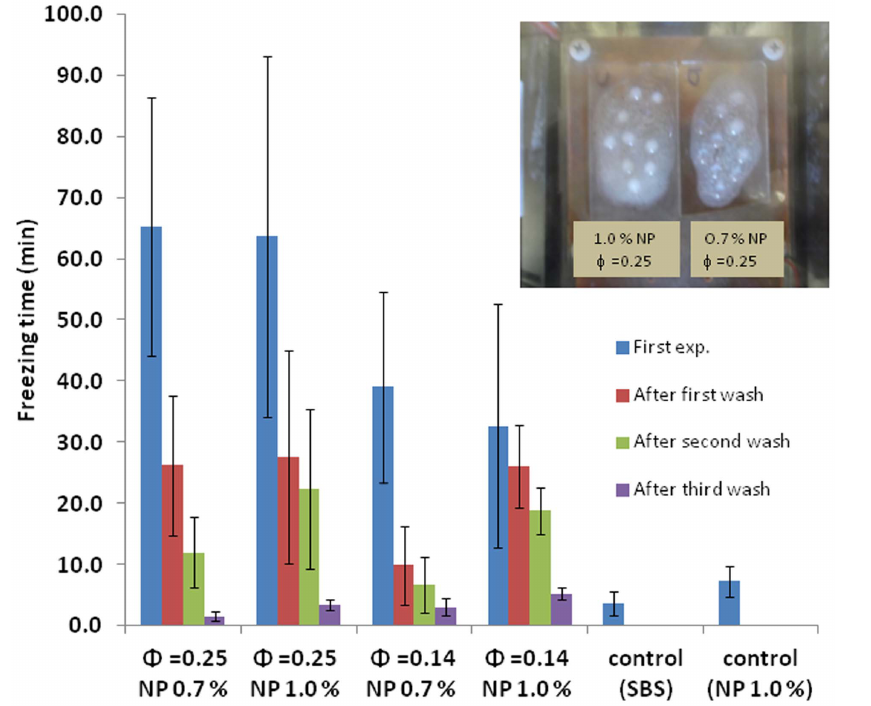
Figure 9. Average freezing times water droplets on dry composite membranes with gelation of the internal phase, SBS (control) and SBS with 1.0% nanoparticle concentration (control). The inset image is taken from temperature and humidity controlled chamber, where the composite with 1% (w/v) nanoparticle concentration (left, W =0.25) and 0.7% (w/v) nanoparticle concentration (right, W =0.25) was monitored at 60 minutes (plate temperature: 2 14 u C, ambient temperature: 5 u C). Data indicates the average of at least three observations with corresponding standard deviations.